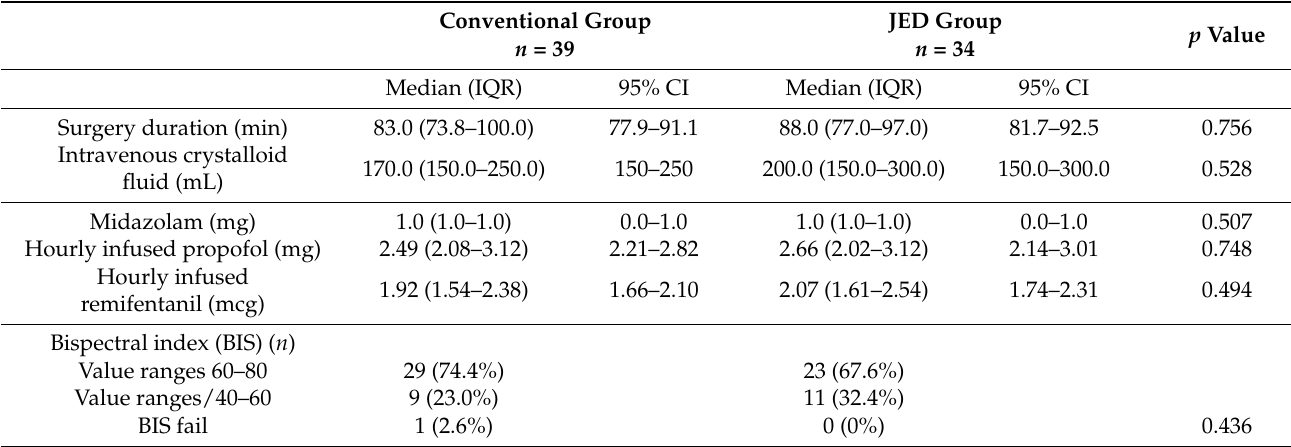
Table 2. Intraoperative sedation data.